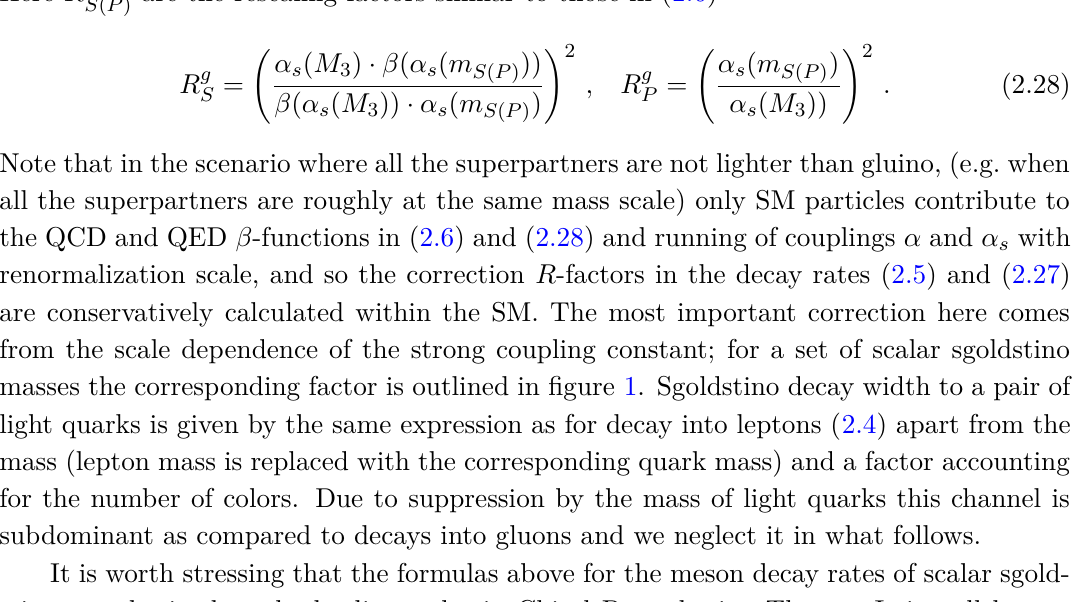
(cid:16) α s ( M 3 ) · β ( α s ( m S )) ≡ S β ( α s ( M 3 )) · α s ( m S )